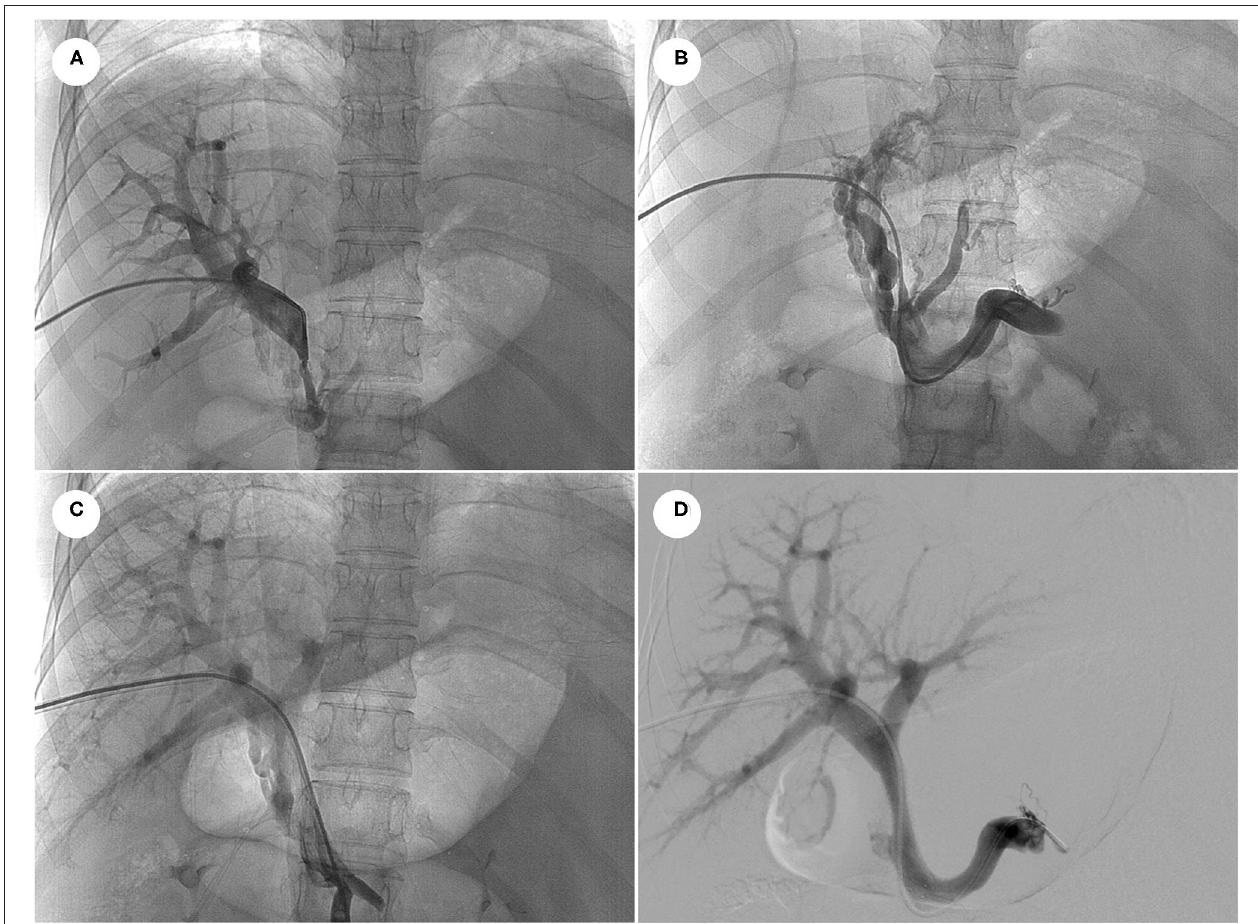
FIGURE 3 | Portal venography showed the main portal vein underwent severely stenosis to be nearly occlusion at the hepatic hilum (A) , and distal portal vein distributed abundant varices to encompass the hepatic hilum (B) . After portal venous angioplasty by balloon dilation (C) and stent implantation (D) , portal vein at the hepatic hilum was clearly displayed, and collateral varices